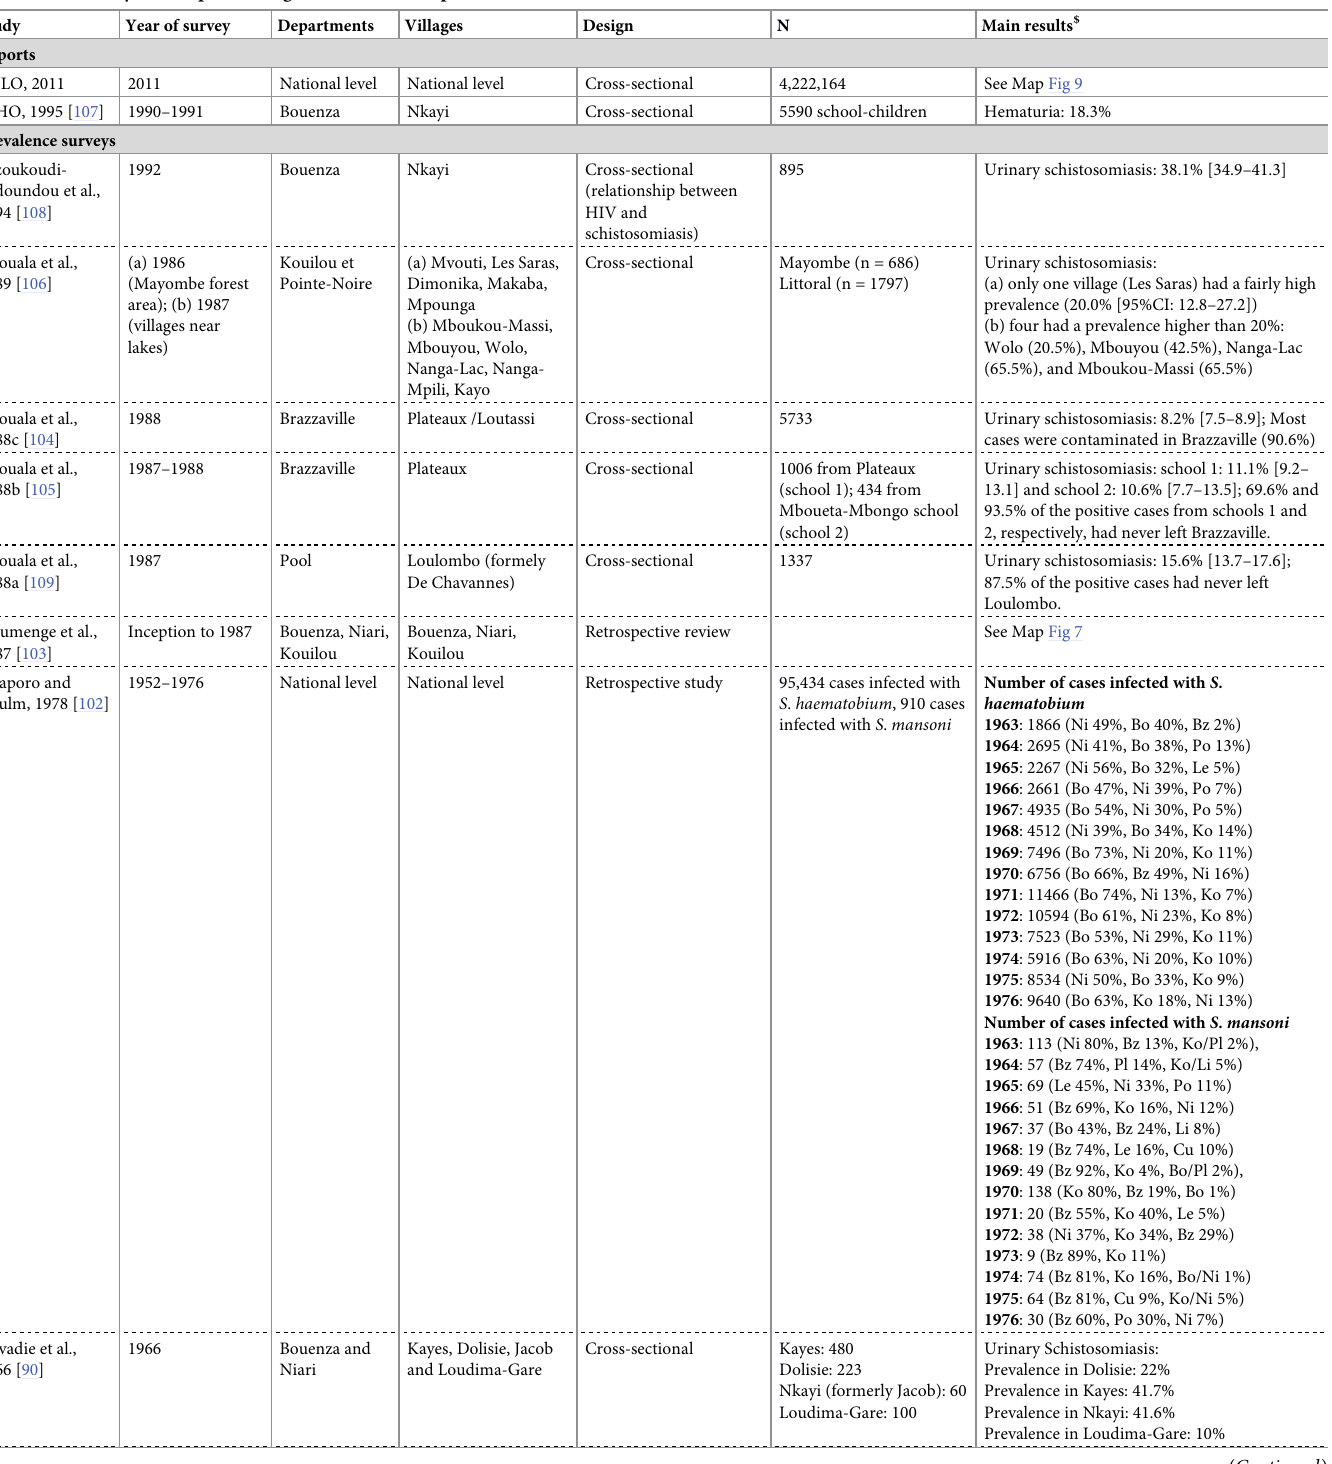
Table 4. Summary of the epidemiological studies and reports on schistosomiasis included in this